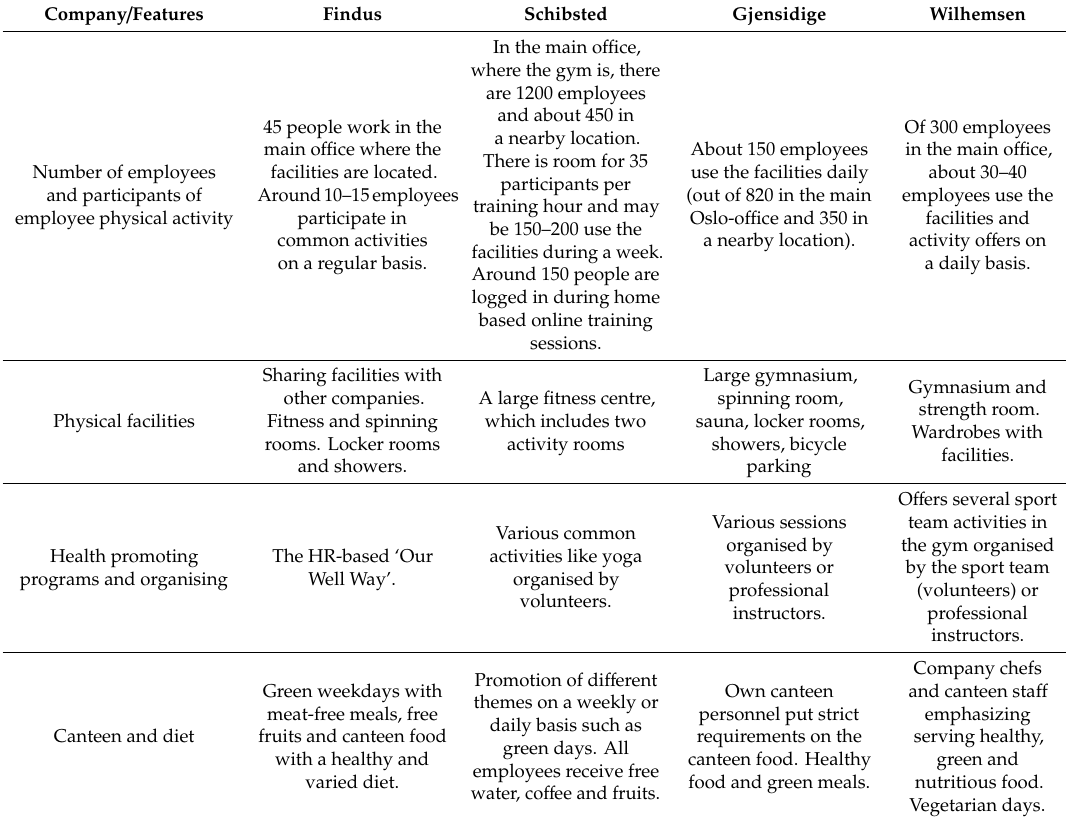
Table 1. Main features of the case